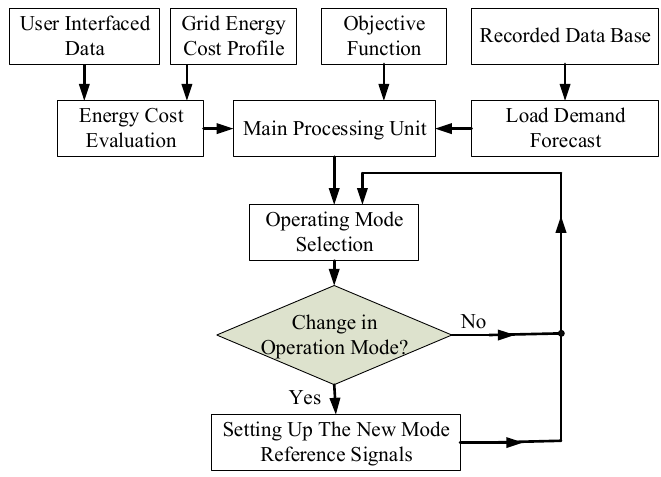
Figure 7. Energy management block diagram in brief.